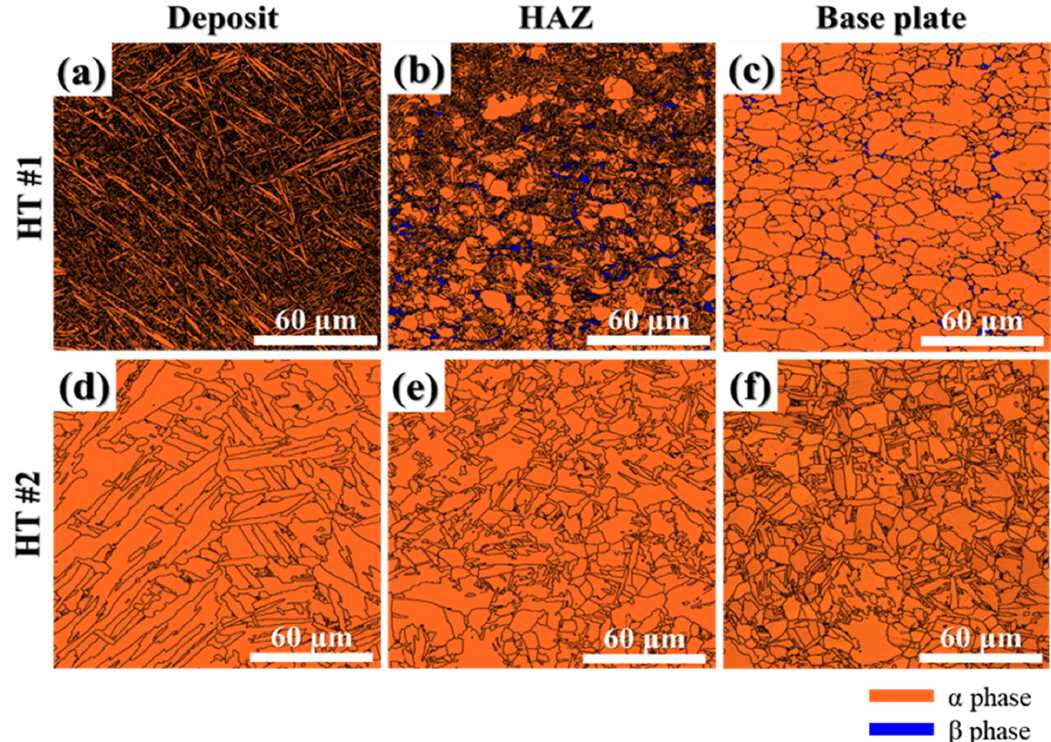
Figure 10. Electron backscatter diffraction–phase maps of the deposition region, HAZ, and base plate of the DED-processed Ti–6Al–4V component after heat treatment: ( a – c ) HT #1, ( d – f ) HT #2. The quantified values of the α and β phase fractions of various samples are plotted in Figure 11a and b, respectively. The hierarchy of the regions in terms of the β fraction is HAZ > base plate > deposition. This can be understood by the heating and solidification behavior of the Ti–6Al–4V alloy during the DED process. Starting from the deposition region where the alloy melts and solidifies rapidly during printing, the resultant micro- structure is martensite. In contrast, the HAZ and the base metal are heated during print- ing, and the heating temperature of the HAZ is significantly higher than that of the base material. Thus, the fraction of β is higher in the HAZ than in the base material. Moreover, the hardness values for the regions (base material, HAZ, and deposit) were measured and illustrated in Figure 12. The as-fabricated sample, starting from the base material with an equiaxed α structure, the hardness value gradually increased along the building direction (base material < HAZ < FZ < deposited material) and attained a maximum value of ~ 392 HV in the deposition region. Considering the notable variation in the microstructure and hardness of the as-fabricated component, such components cer- tainly alter the performance of the entire part (anisotropic nature). Therefore, it is im- portant to achieve a nearly homogeneous microstructure and properties throughout the fabricated components. The hardness variation in the component after HT #1 condition shown in Figure 12b. It can be noticed that the values are nonuniform. Finally, the hard- ness values at various locations of the component after HT #2 are plotted in Figure 12c. In contrast to the other two samples (as-fabricated and HT #1), the hardness value of the HT #2 component does not vary with the location and shows a constant value of ~ 350 ± 10 HV, as depicted in Figure 12c. Therefore, on the basis of the microstructure and hardness results, HT #2 is beneficial for fabricating DED-processed components with homogeneous